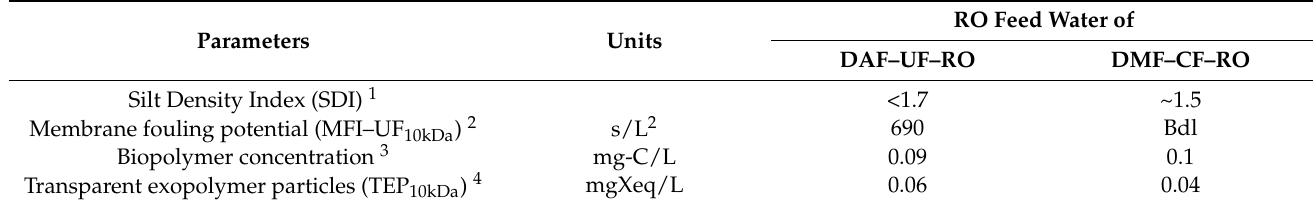
Table 5. RO feed water quality measured regarding SDI, MFI–UF, LC–OCD, and TEP.